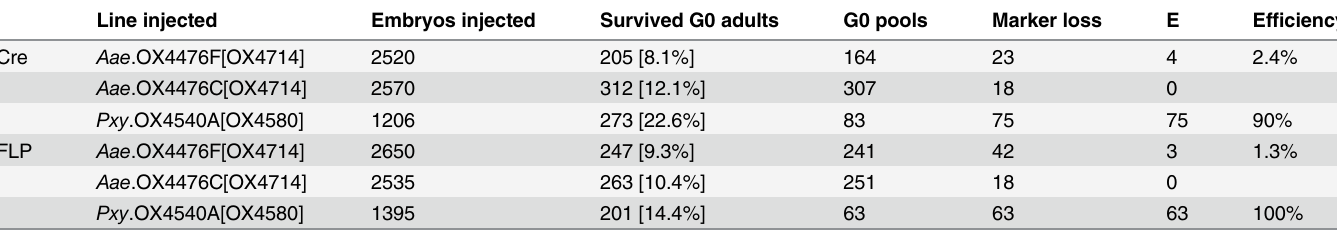
Table 4. Summary of Ae . aegypti and P . xylostella injections for Cre and FLP injections. Line